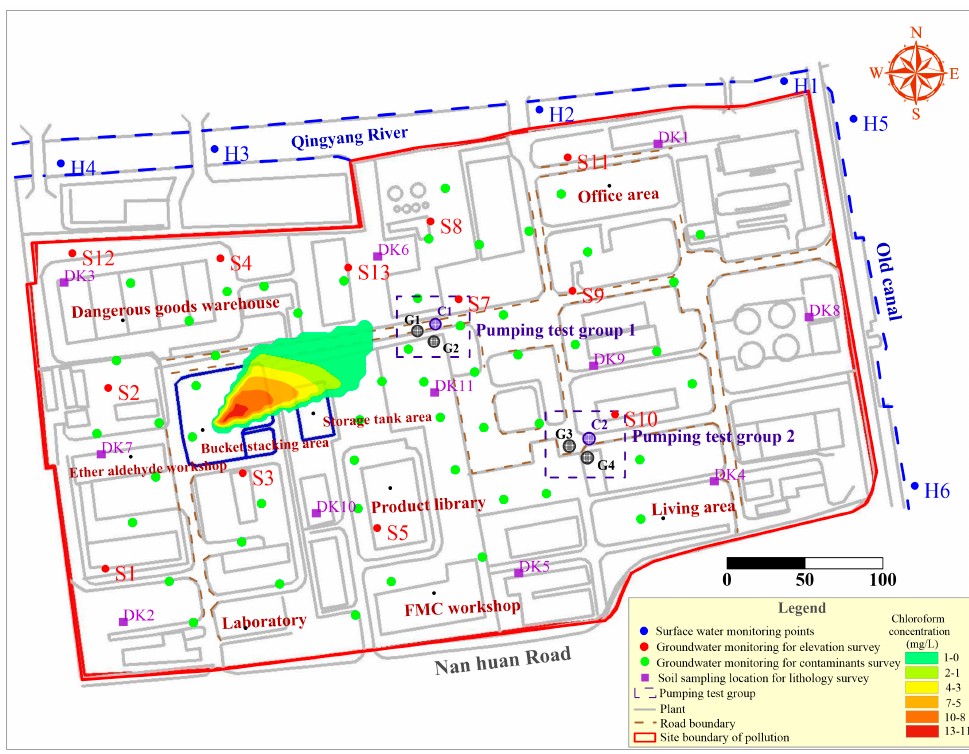
Figure 6. Contour map of chloroform concentration in the study area.